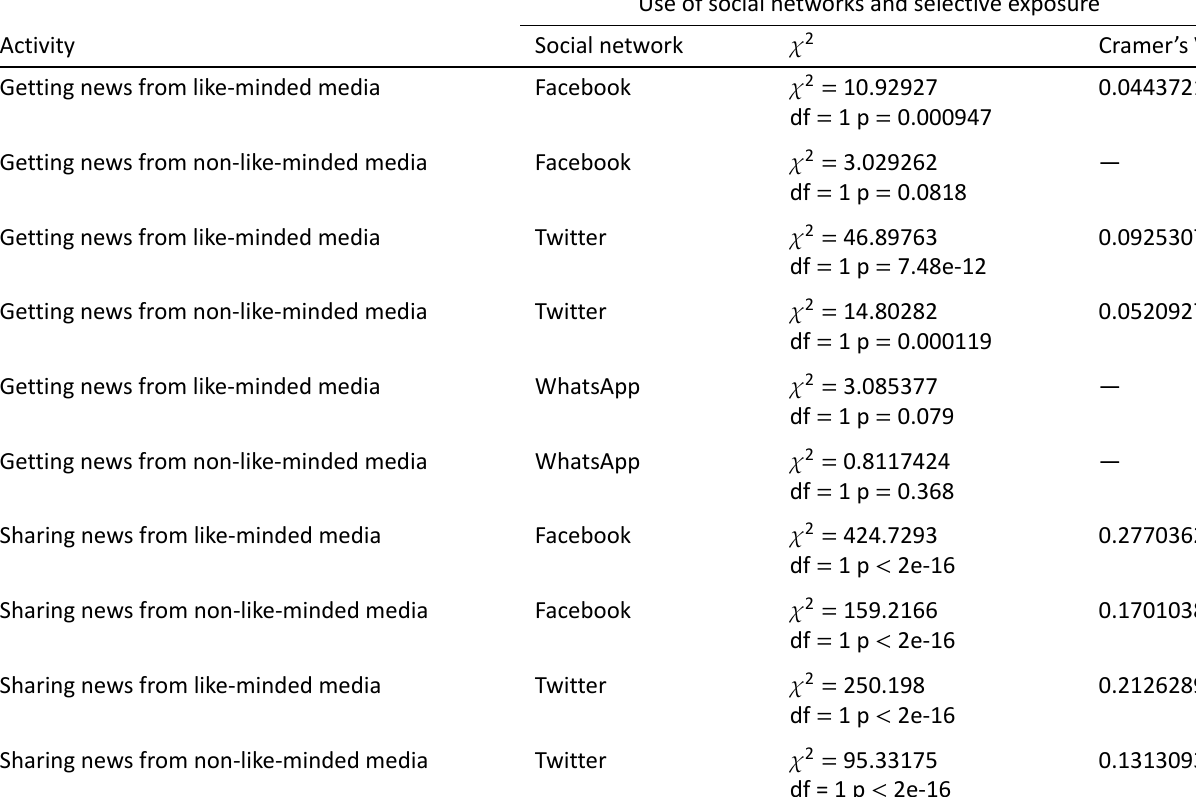
Table 4. Chi-square test for